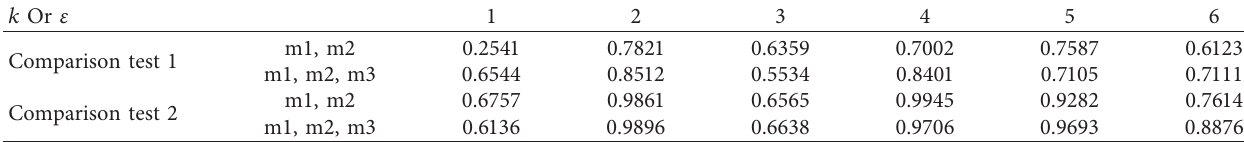
Table 9: The ε between the two fusion